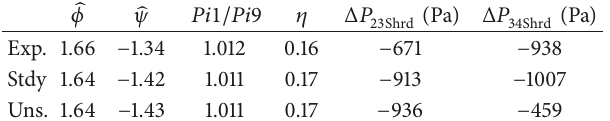
Table 4: Synthesis of experimental and numerical global perfor- mance.